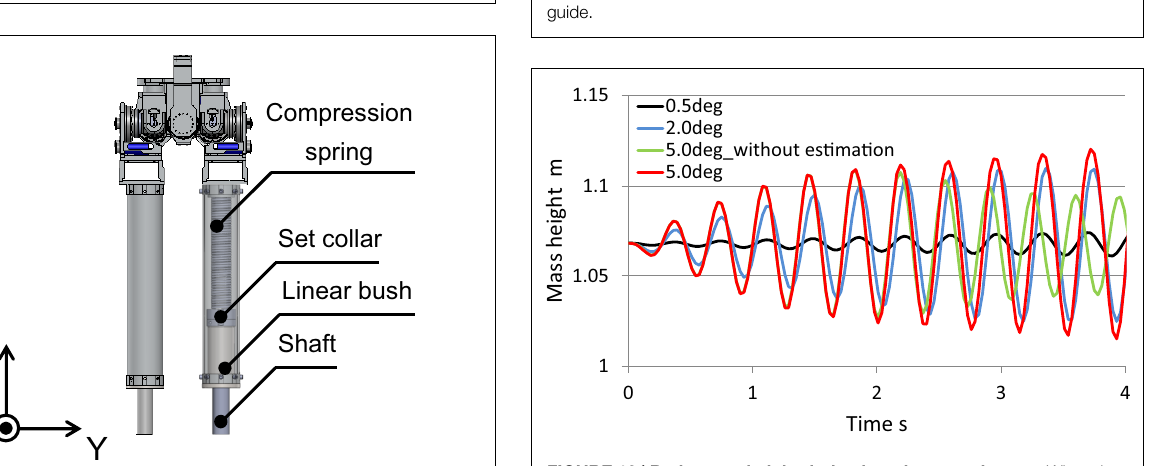
FIGURE 10 | Body mass height during hopping experiments . When the leg took off the ground, the mass height was 1.1m. A mass height above 1.1m indicates that the robot hopped. When the amplitude of the pelvic oscillation was 0.5°, the robot could not hop. When the amplitude was more than 2°, the robot successfully hopped after a few oscillations. In the experiment without the landing time estimation, however, the robot could